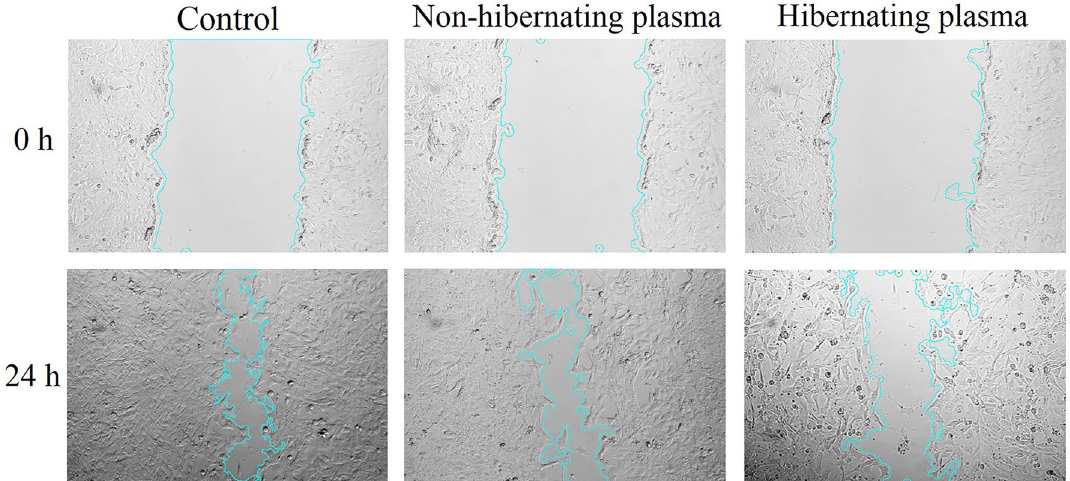
Figure 5. Effect of hibernating plasma on the migration of cancer cells according to the wound healing assay. Light microscope photographs of the scratched area immediately after wound formation (0 h) and after 24 h incubation with non-hibernating plasma (16 mg/ml) and hibernating plasma (16 mg/ml). The control wells were incubated with standard cell culture media. The wound area was quantitatively analyzed by the Wound Healing Size Tool , an ImageJ/Fiji1